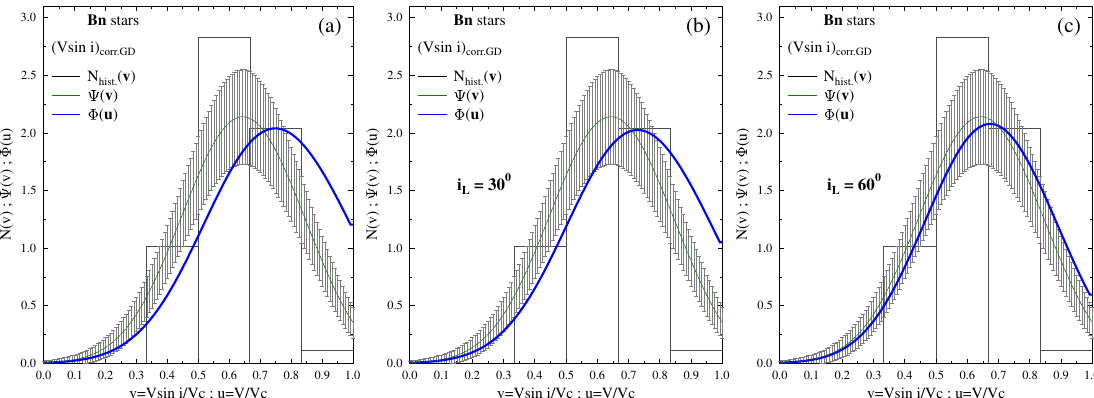
Figure 36. Distributions of ratios of rotational velocities of Bn stars correction for GD effects. ( a ) Histograms of velocity ratios v = V sin i / V c ; functions Ψ (v) are the smoothed histograms after correction for observational uncertainties (green curves); functions Φ ( u ) are distributions of true velocity ratios u = V / V c (blue curves). ( b , c ): histograms, functions Ψ ( v ) from ( a ) and distributions of true velocity ratios u = V / V c corrected for GD effect and for the density probabilities of inclination angles bridled at inclinations i L = 30 ◦ and i L = 60 ◦ , respectively. Adapted from Cochetti et al.